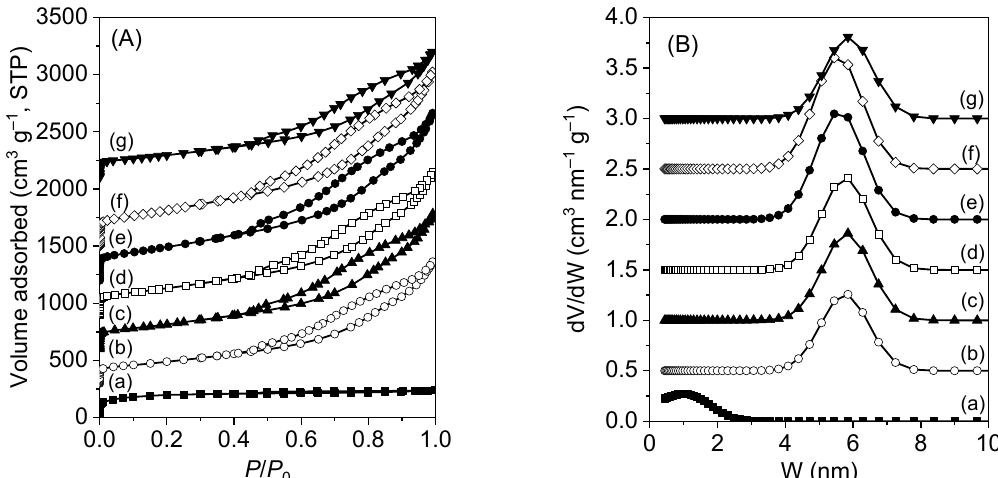
Figure 2. ( A ) N 2 adsorption-desorption isotherms and ( B ) NLDFT pore size distributions of the